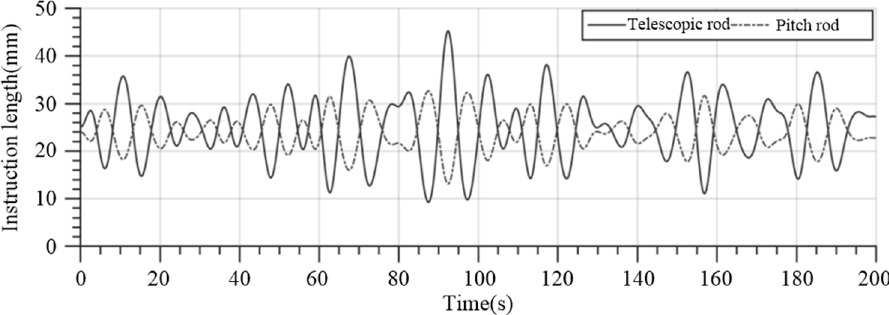
Figure 17. Command length of gangway telescopic rod and pitch rod when the ship is equipped with passive anti-rolling tank.